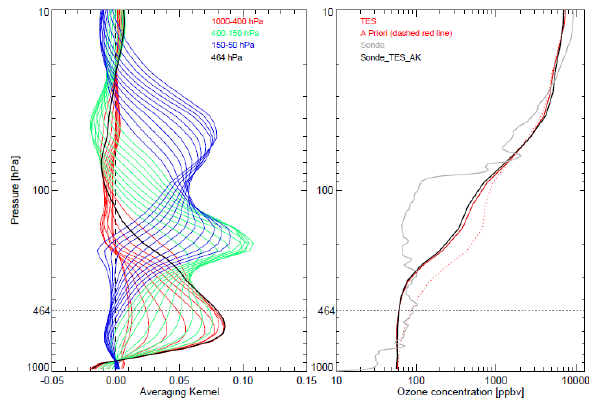
Figure 2. Left panel: typical averaging kernel of the vertical ozone profile as provided by TES over De Bilt, the Netherlands (latitude: 52.10˚, longitude: 5.18˚, altitude: 9 m, 14 July 2005, 11h23 UTC) for a clear day (DOF = 3.98, with high sensitivity from the 1000-400 hPa range). Right panel: corresponding ozone profiles observed by the ozonesonde launched at De Bilt (grey), retrieved by TES (red), and the ozonesonde profile as TES would observe it (after application of the TES AK), in black. The dashed red line indicates the MOZART a priori O 3 profile as used in the TES retrieval.